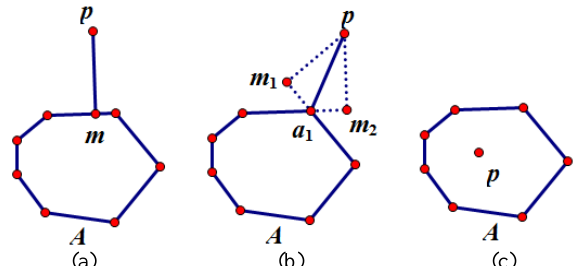
Fig2 Distance from point to polygon in different cases. (a) The pedal is on an edge. (b) The pedal is not on an edge. (c) Point is inside of the polygon.